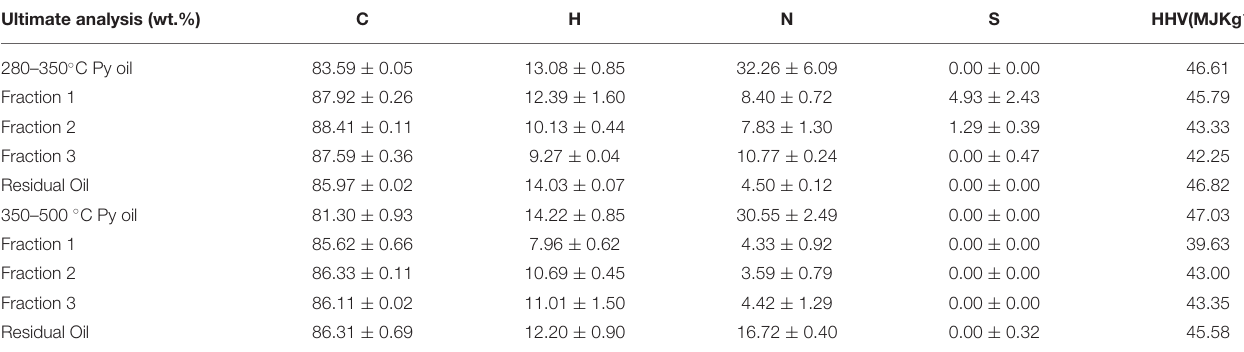
TABLE 7 | Ultimate and HHV analysis for pretreated ASR pyrolysis oil and its distillates. Ultimate analysis